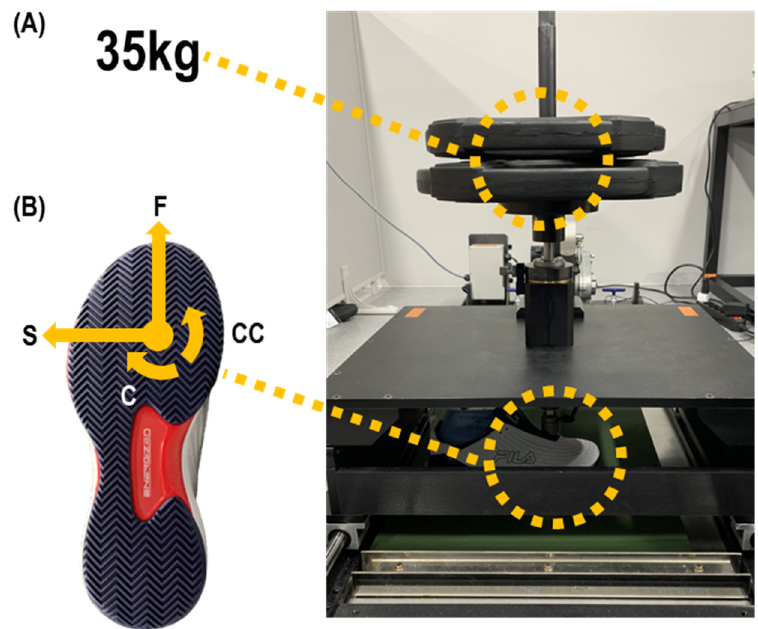
Figure 2. Frictional force measurement and measurement direction through mechanical test. (( A ): Applied Vertical load of the mechanical test, ( B ): Direction of CoF and rotational frictional force of shoes through mechanical test).